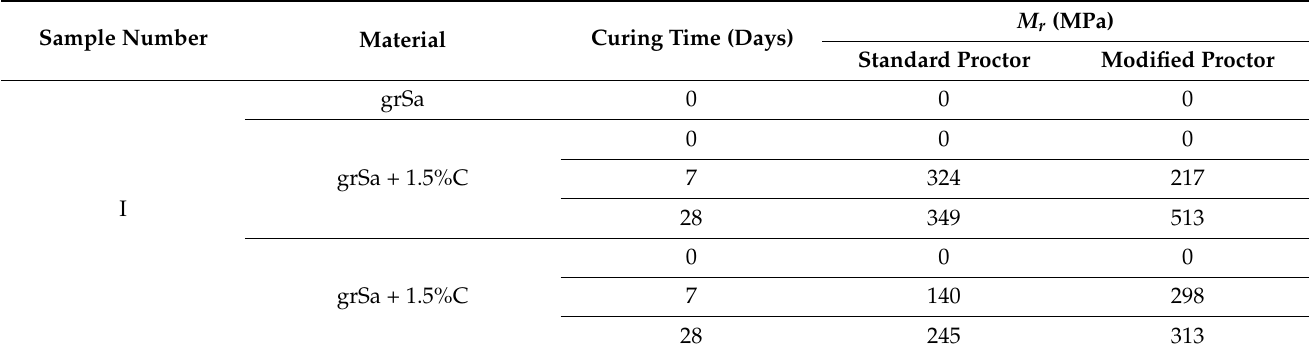
Table 4. Resilient modulus test